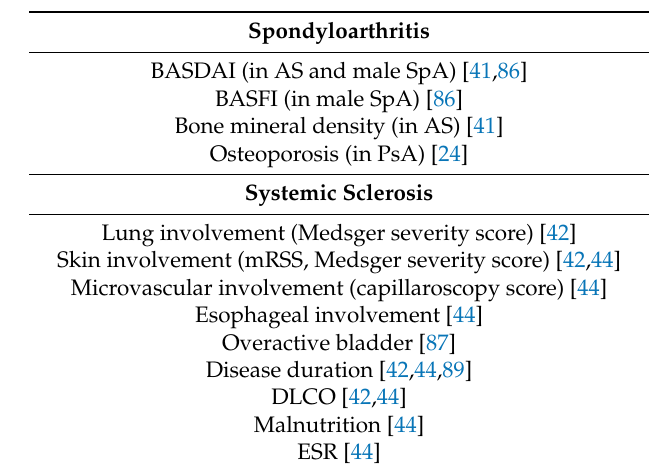
Table 3. Associated Factors Related to Sarcopenia in Patients with Rheumatic Diseases Other Than Rheumatoid